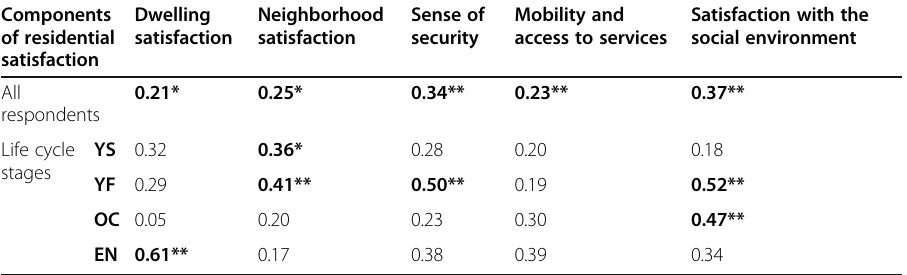
Sense of Mobility and security access to services